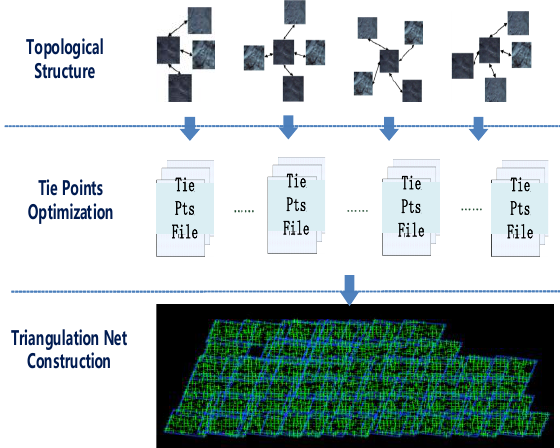
Figure 1. Flow chart of multimode image triangulation model